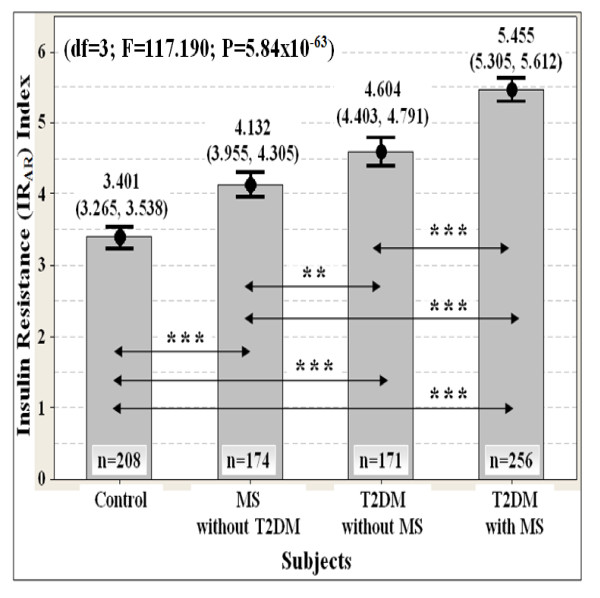
Evaluation of insulin sensitivity with the insulin resistance (IRAR) index (n = 809). Data are expressed as mean (95% confident interval). ANCOVA test was used, followed by pairwise comparison using 1,000 stratified bootstrap samples with bias corrected and accelerated (BCa) 95% CI for multiple testing bias corrections due to deviation of normality. The p-value was also adjusted for covariate ages with stratified ethnicity. The location of statistically significant differences are displayed as the double arrow. Significant levels: P* < 0.05, P** < 0.01, P*** < 0.001. Note: T2DM = type 2 diabetes; MS = metabolic syndrome.